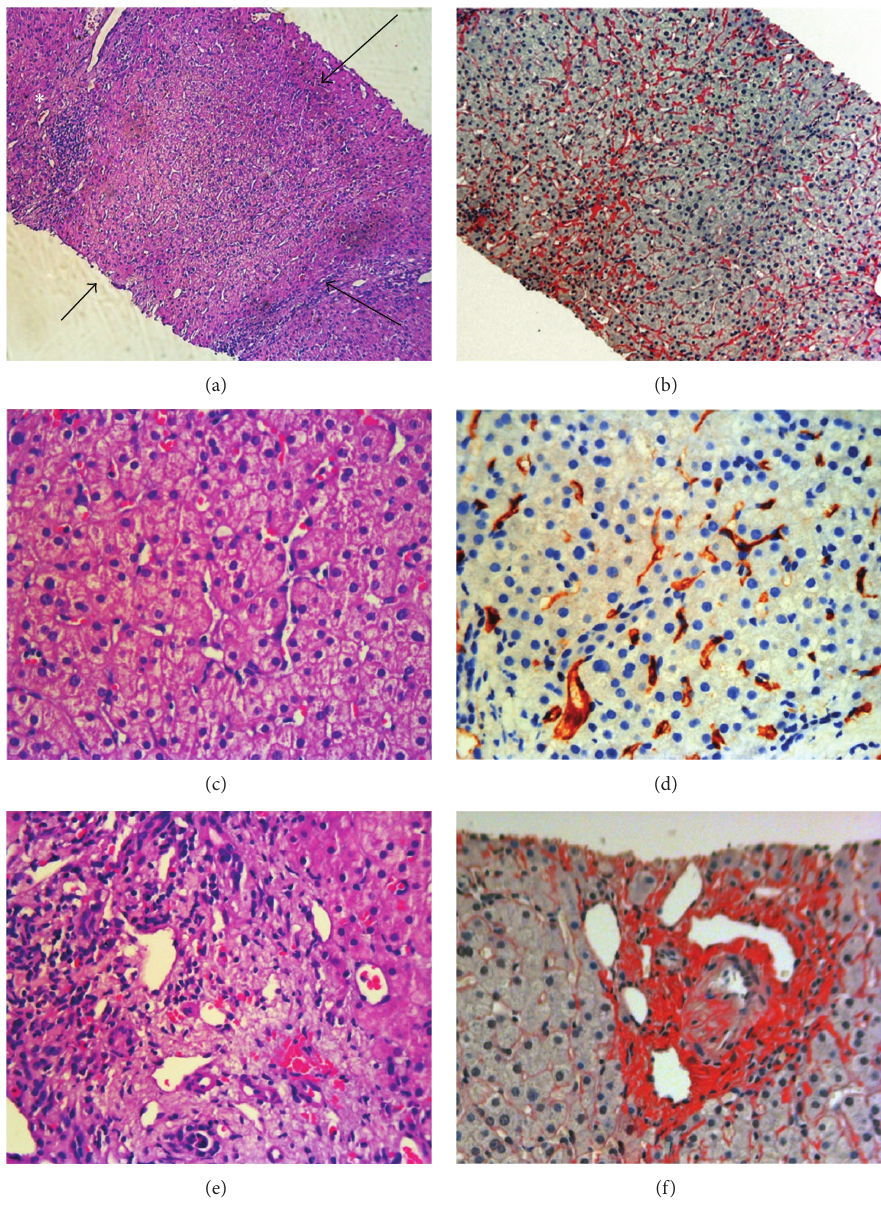
Figure 3: Liver biopsy from patient 2 showing features of nodular regenerative hyperplasia. (a-b) Liver parenchyma shows nodules with expanded liver plates surrounded by a rim of atrophic hepatocytes (arrows), in absence of fibrous septa. Portal lymphohistiocytic inflammatory infiltrate with interface activity (white asterisk) is also present ((a) hematoxylin and eosin stain, original magnification 10x; (b) Sirius Red stain, 10x). Congested and dilated sinusoids (megasinusoids) are shown in (c) and (d) ((c) hematoxylin and eosin stain, original magnification 20x; (d) CD34 immunostaining, original magnification 20x); (e) aberrant vascular structures within the portal tract (hematoxylin and eosin, original magnification 20x); (f) fibrotic portal tracts (Sirius Red stain, original magnification 40x).